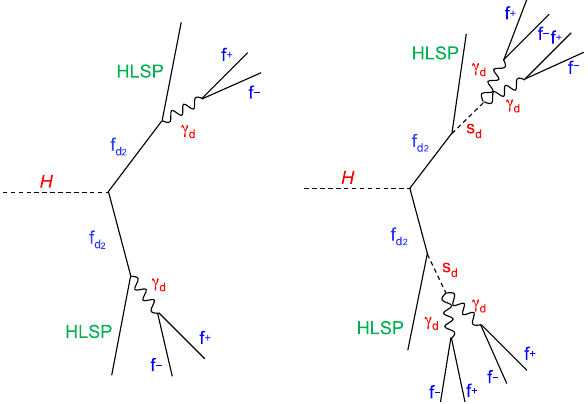
Fig. 1 The two processes of the FRVZ model used as benchmarks in the analysis. In the first process (left), the dark fermion f d into a γ d and an HLSP. In the second process (right), the dark fermion f d decays into an HLSP and a dark scalar s d that in turn decays into a 2 pair of dark photons. The γ d decays into SM fermions, denoted by f + and f